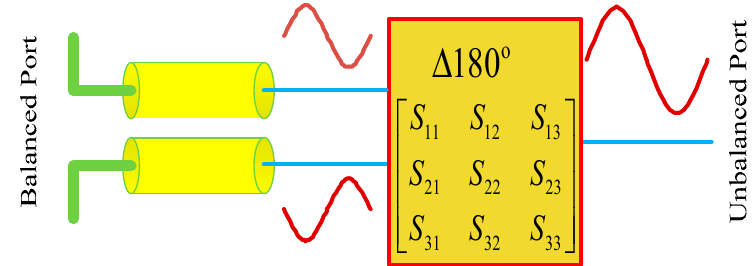
Figure 2. Diagram of the balun transferring the differential mode to the common mode.